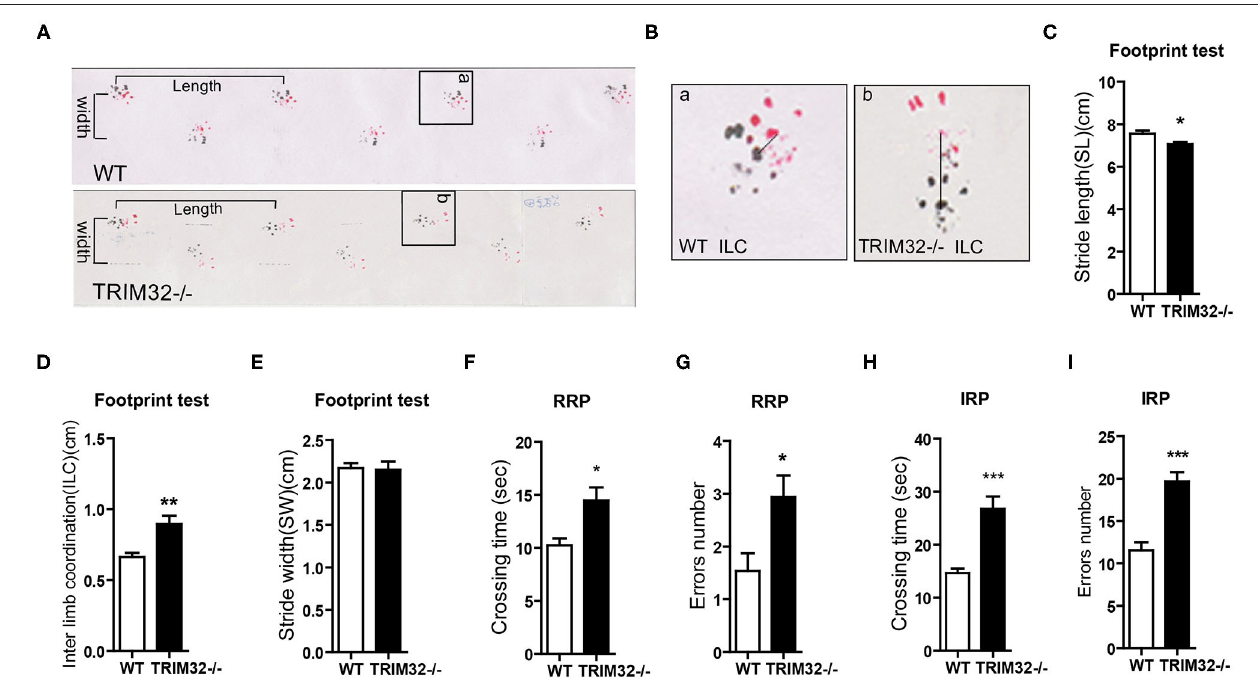
FIGURE 1 | TRIM32 deficiency impairs balance and motor control. (A) Representative footprint patterns of adult WT and TRIM32 − / – mice. Stride length and stride width are shown. (B) High magnified images of indicated areas in (C) show the inter limb coordination of TRIM32 − / – and controls. (C–E) Footprint patterns were quantitatively assessed for stride length (C) , inter limb coordination (D) , and stride width (E) . (F–I) The ladder rung task was used to evaluate motor coordination. Quantitative analysis of the crossing time and number of limb errors with the regular rung pattern (F, G) and the irregular rung pattern (H, I) . The performance of TRIM32 − / – mice was poor. Data are presented as the mean ± SEM. Footprint test: n = 11 ( TRIM32 − / – mice), = 12 (WT mice); Ladder rung task: n = 13 ( TRIM32 − / – mice), = 15 (WT mice). * p < 0.05, ** p < 0.01, *** p < 0.001.